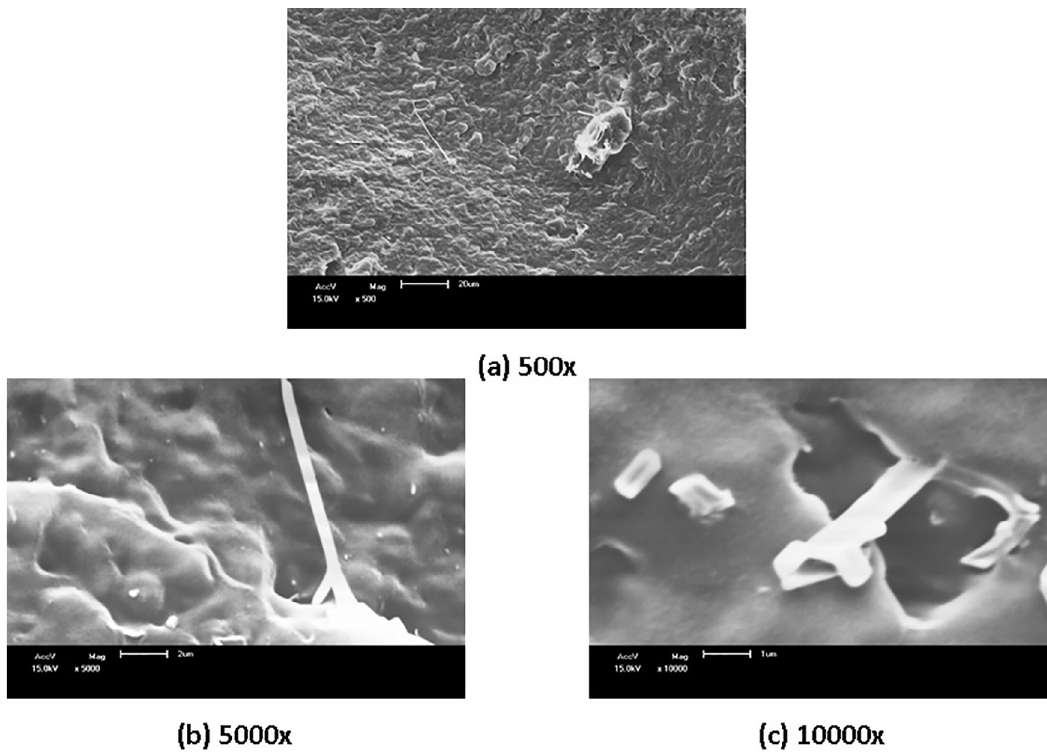
Figure 11. SEM images of PCL/PCL-g-MA/MMT in different magnifications, 500x, 5000x and